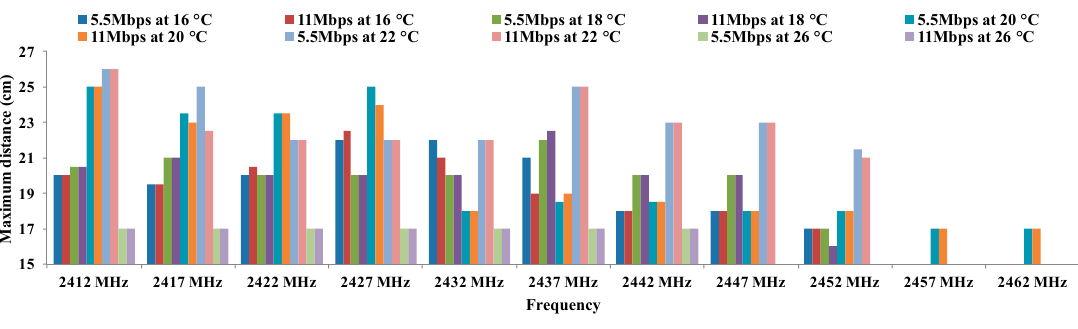
Figure 10. Maximum distances for CCK.